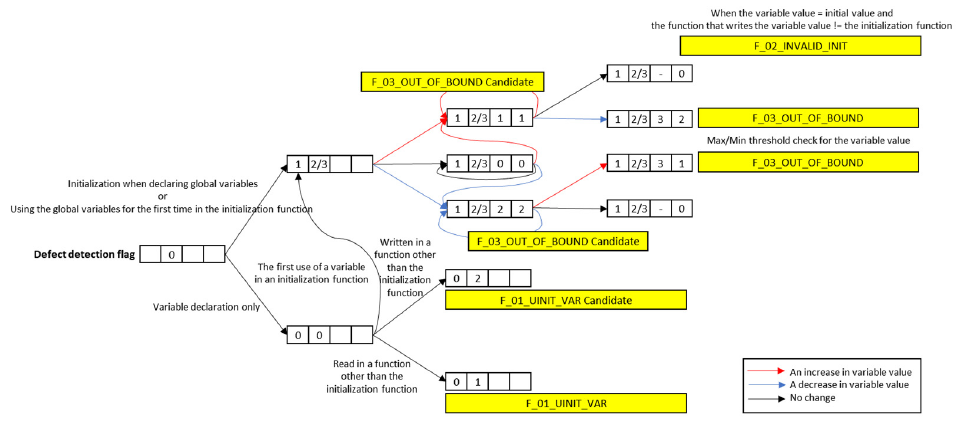
Figure 6. Defect detection algorithm.